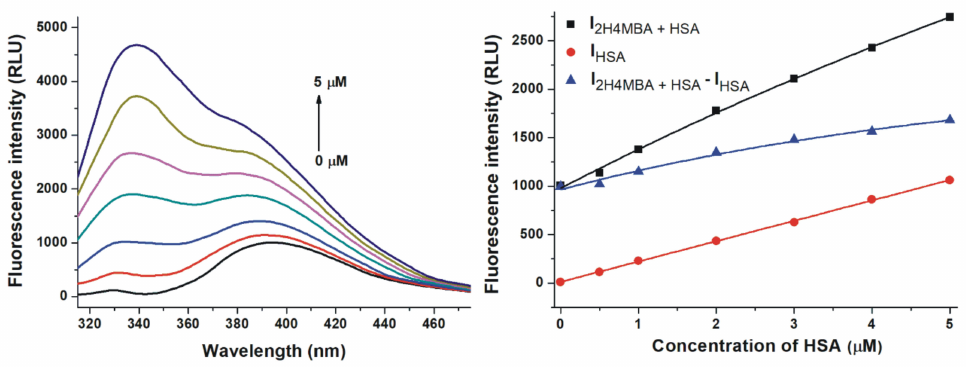
E ff ect of human serum albumin (HSA) on the fluorescence emission signal of 2-hydroxy-4-methoxybenzoic acid (2H4MBA). Left: Representative emission spectra of 2H4MBA (2 µ M) in the presence of increasing concentrations of HSA (0, 0.5, 1, 2, 3, 4 and 5 µ M) in PBS (pH 7.4). Right: Fluorescence emission intensity of 2H4MBA in the presence of increasing concentrations of HSA (I 2H4MBA + HSA ), HSA alone (I HSA ), and I 2H4MBA + HSA – I HSA in PBS (pH 7.4; λ ex = 295 nm, λ em